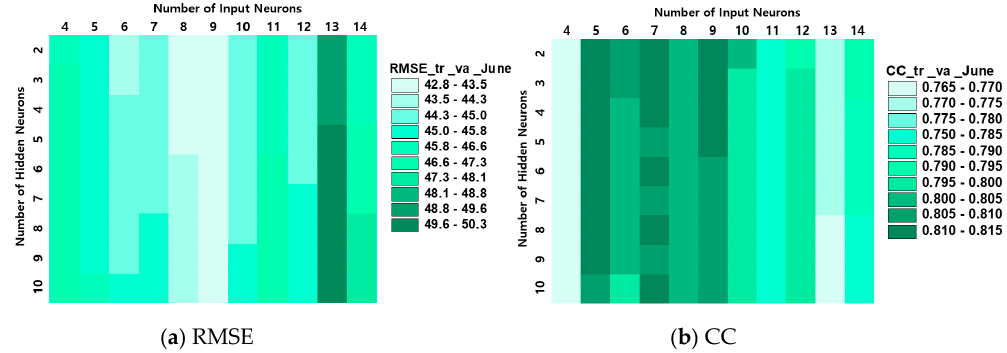
Figure 4. Performance of the ANN-J model ( a ) root mean squared error ( b ) correlation coefficient.